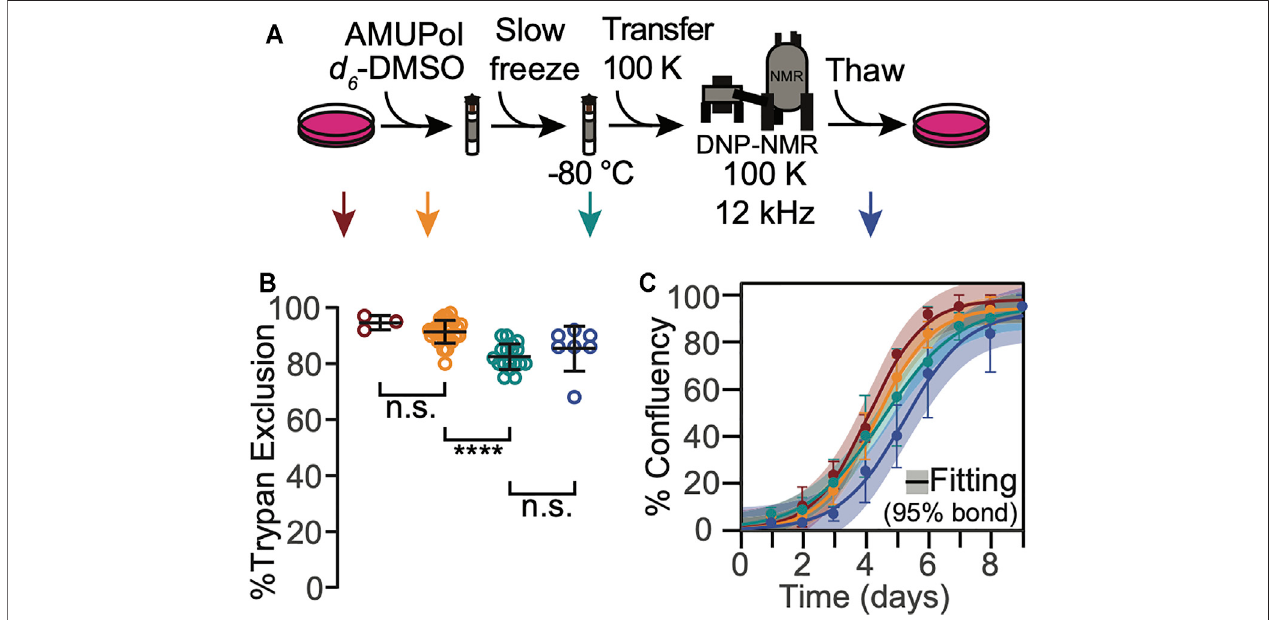
FIGURE 1 | HEK293 cells that are cryopreserved with 10% DMSO are viable throughout the DNP NMR process. (A) . Experimental scheme of the DNP NMR sample preparation procedure. Colored arrows indicate points at which sample viability was assessed. Viability was assessed for cells after trypsinization and washing (darkred),aftersuspensioninAMUPolandcryoprotectants(orange),afterbeingfrozenat1 ° Cpermin(green),andaftertheentireDNPMASNMRexperiment(blue). (B) Percentage of cells with trypan impermeable membranes at each sample assessment point, colored as in A. Each point represents an independent sample. Black barsindicateaverageandstandarddeviation.Bracketsindicateresultsoftwo-tailedhomoscedasticstudent ’ s t -tests.(n.s. p > 0.05,**** p < 0.0001). (C) Growthkinetics asassessedbycon fl uency,coloredasinA.Theaveragesandstandarddeviationsofthreeindependentexperimentsareindicatedbycirclesanderrorbars,respectively. The best fi t of sigmoid is indicated in solid lines and the 95% con fi dence interval by the shaded